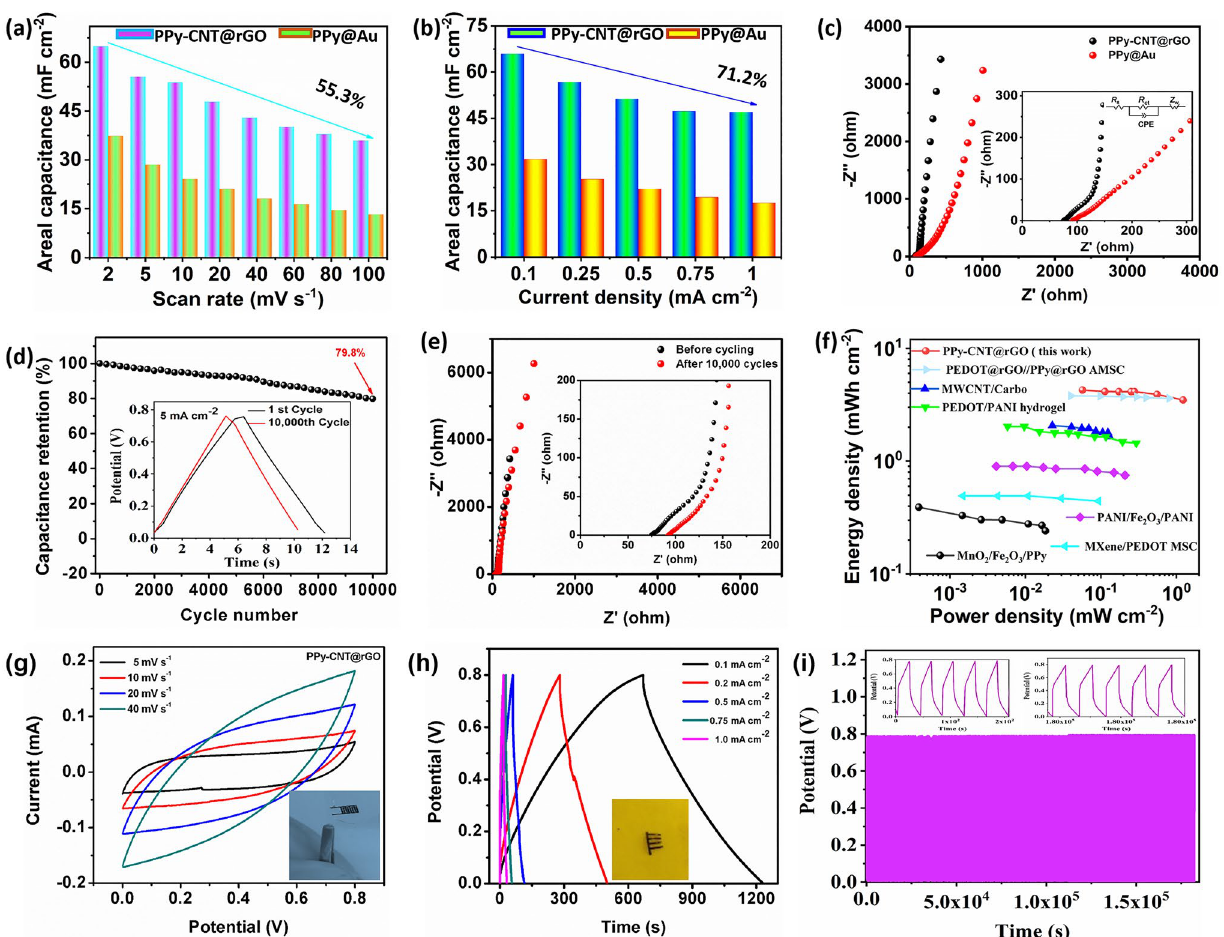
Fig. 5 a, b Areal capacitance as a function of scan rate and current density for PPy@Au and PPy-CNT@rGO MSCs. c EIS curves of the fabri- cated solid-state MSCs, and the inset shows its zoom view at the high-frequency region. d Cycling stability of MSC measured at a very high cur- rent density of 5 mA cm −2 within a voltage window of 0.8 V. e EIS curves of the fabricated solid-state MSC before and after 10,000 cycles. The inset shows its zoom view at high-frequency region. f Ragone plot revealing areal energy density vs. power density of PPy-CNT@rGO MSC in comparison with recently reported CPs-based MSCs [49–52]. g, h, i CV, GCD and cycling stability curves of current collector-free PPy-CNT@ rGO flexible